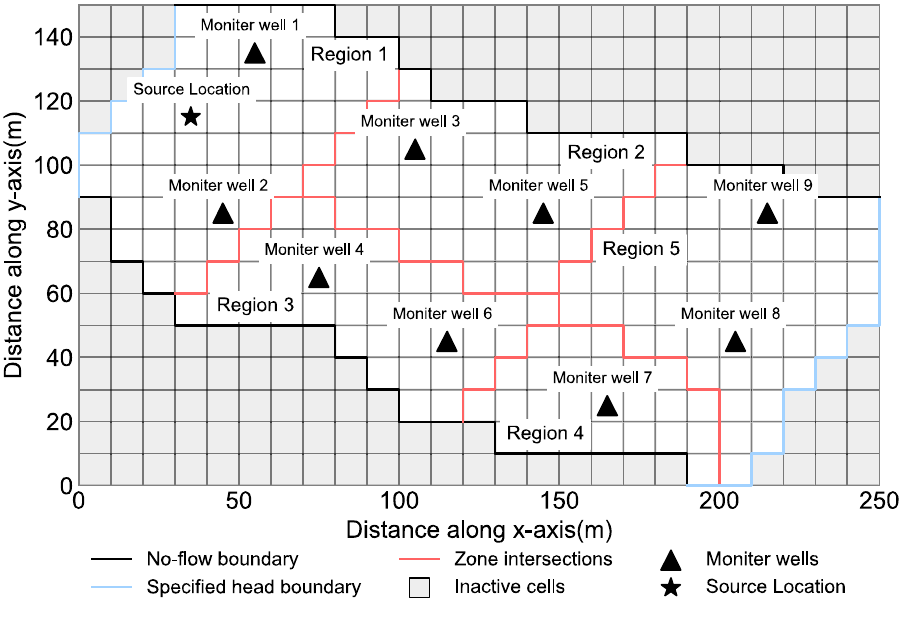
Figure 4. Basic information for case 1. Table 2. Hydrogeological parameters of case 1.